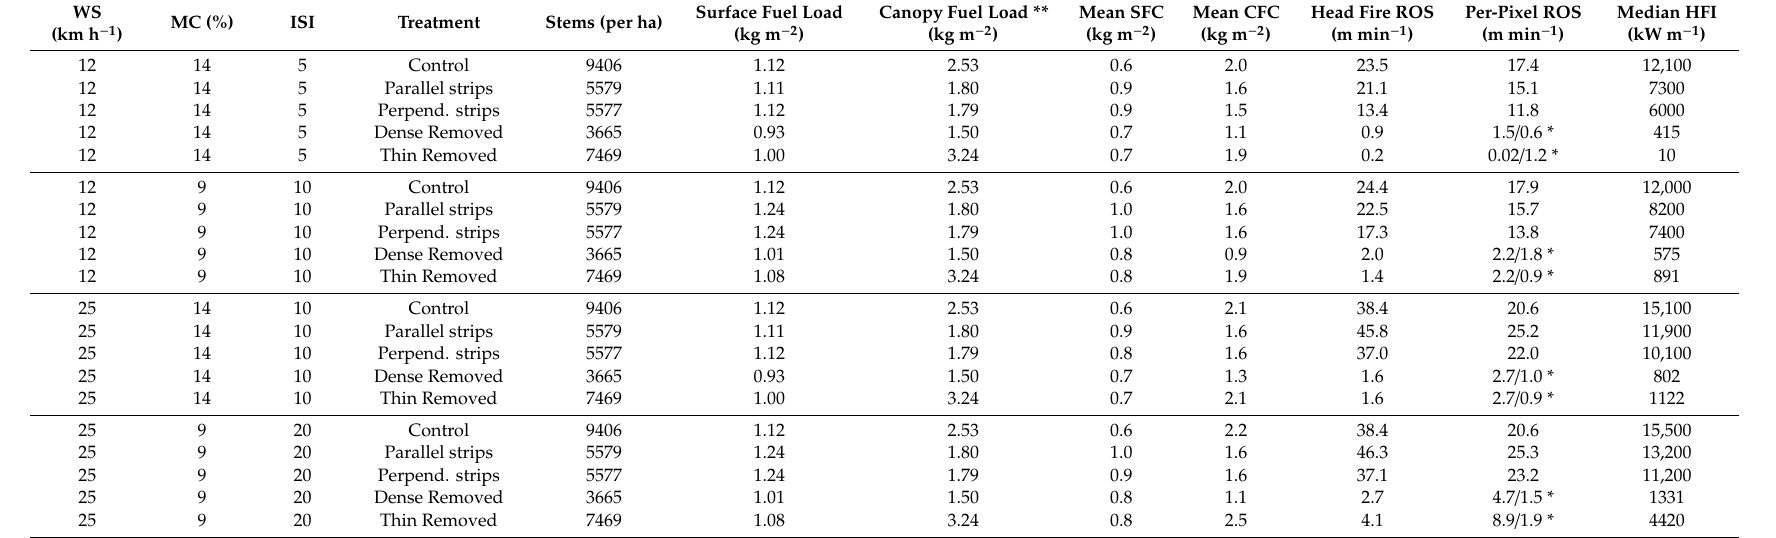
Table 2. Head fire rate of spread (ROS), median per-pixel ROS, head fire intensity (HFI), crown fuel consumption (CFC), surface fuel consumption (SFC), surface fuel load, canopy fuel load and number of stems for each scenario. The mean stand height and live crown base height are 12 m and 2.4 m respectively for all scenarios. * Median per pixel rate of spread with flank fire. ** Average canopy fuel load for cells with canopy